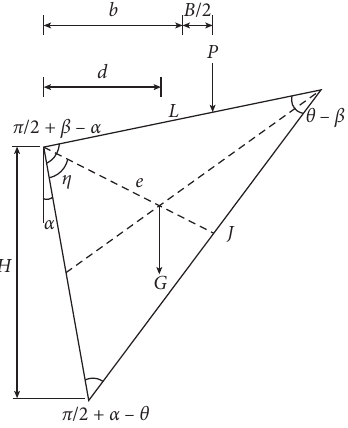
Figure 3: Correlations of the geometric parameters of the probable failure